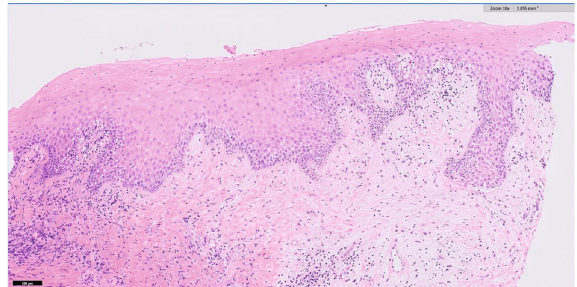
Figure 12: Histopathological slide of gingival biopsy revealed squamous epithelium hyperplasia with underlying chronic in fl